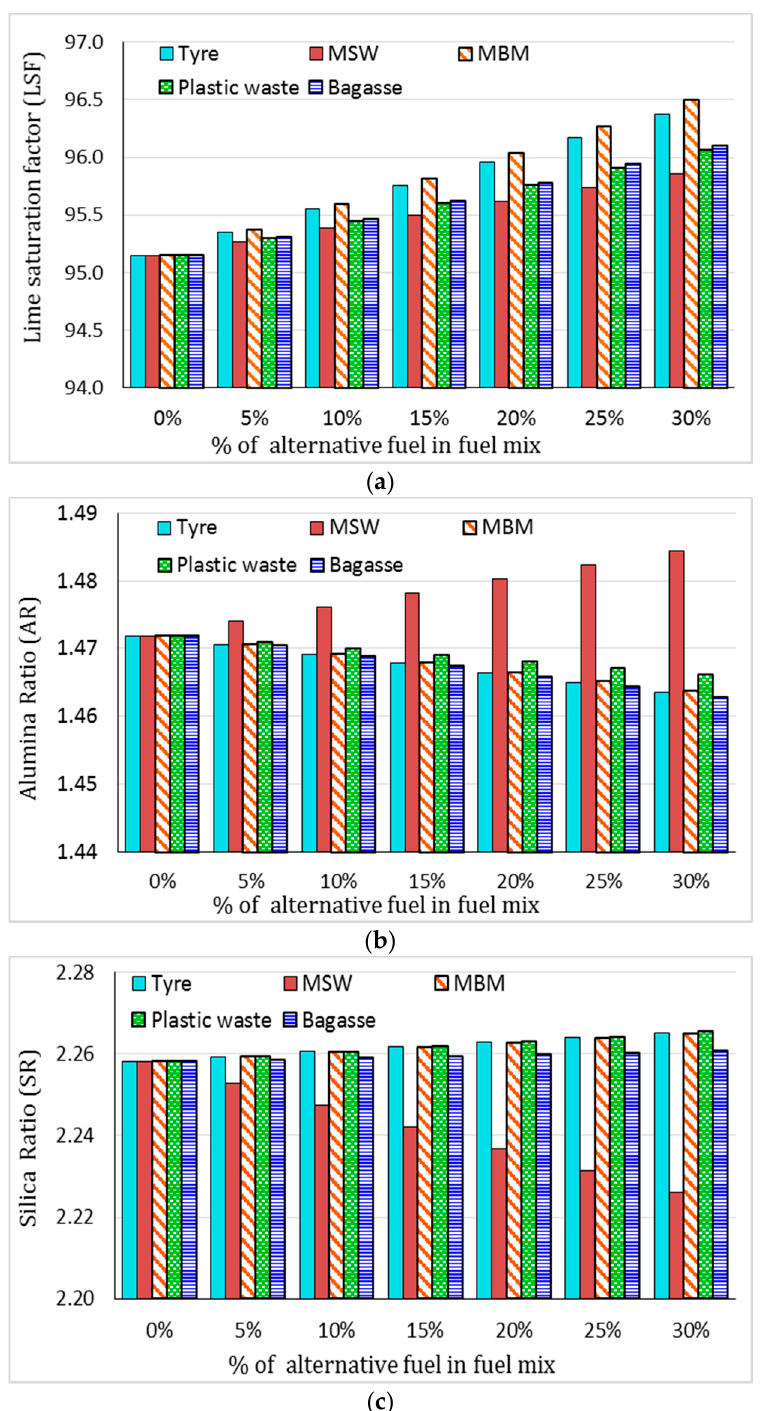
Figure 7. Impact on clinker quality ( a ) LSF ( b ) AR and ( c ) SR.